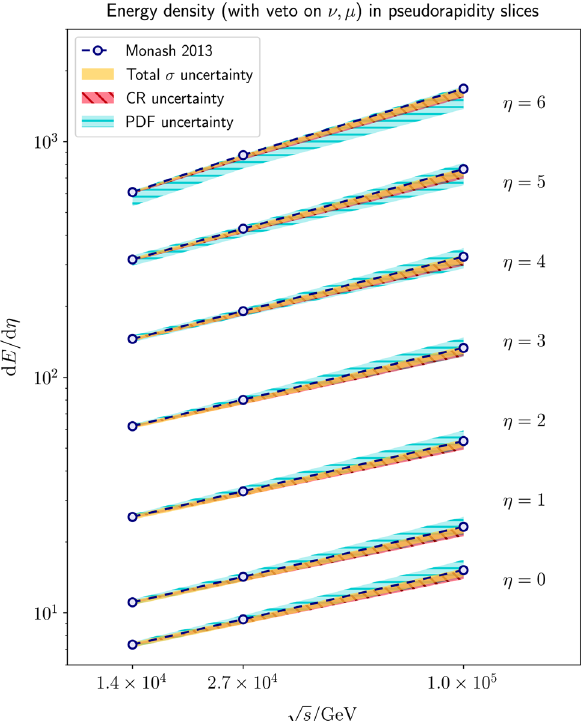
Fig. 9 Plotsshowingthescalingoftheenergydensityofchargedtracks in slices of η as a function of collider CM energy